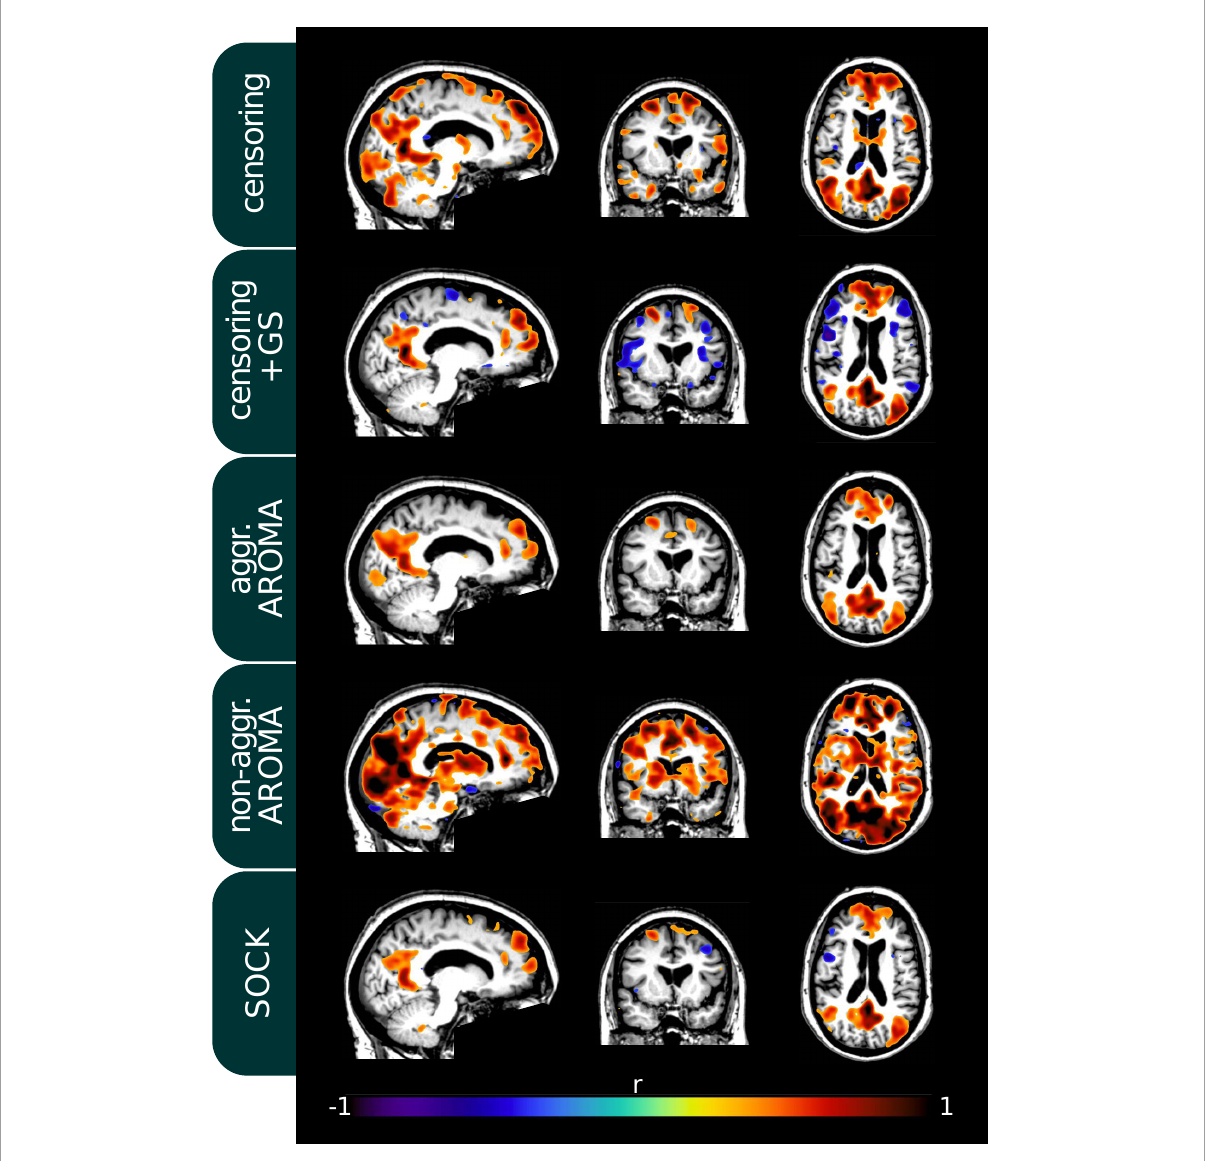
FIGURE5 Connectivity of the default mode network (DMN) of an example subject after each regression procedure. Motion parameters for this subject can be found in Figure 1 . As seen on average in Figure 4 , the usage of the global signal regressor (GS) introduces task-positive anticorrelations, which can also be observed with the SOCK approach. The censoring approach without global signal regression exhibits minor motion-induced edge activity, which is more pronounced in the non-aggressive AROMA approach, where extensive amounts of false-positive connectivity can be observed across the whole brain. The aggressive AROMA approach produces the cleanest DMN map, while SOCK and censoring + GS regression approaches perform